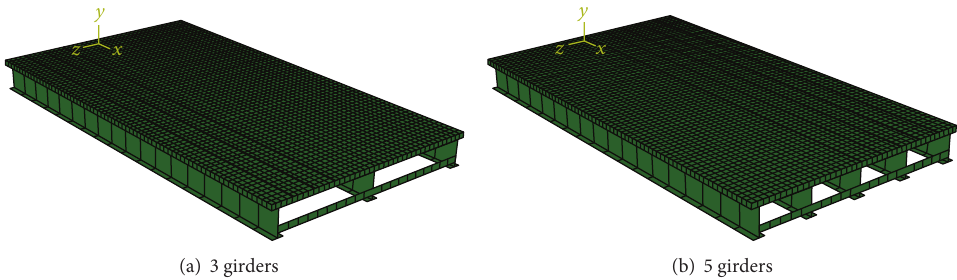
Figure 5: Finite element model of the composite bridges with CFRP deck.